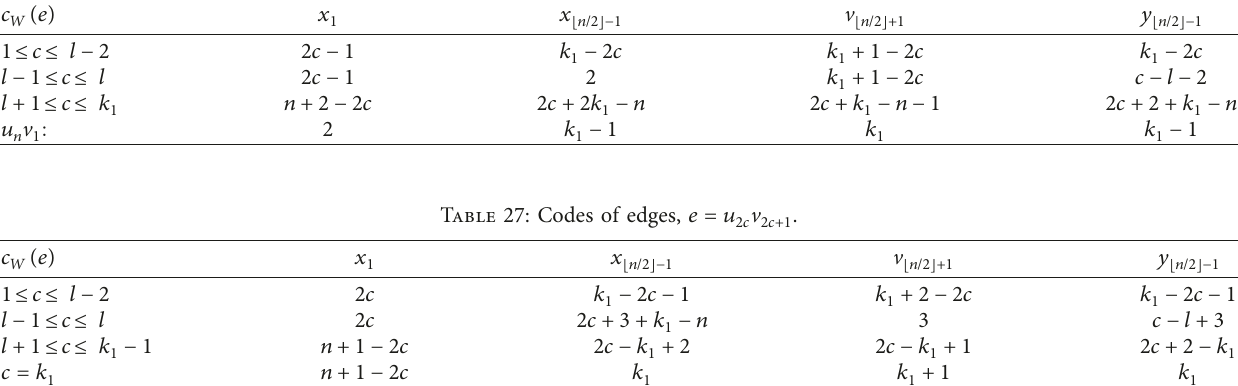
Table 26: Codes of edges, e � u